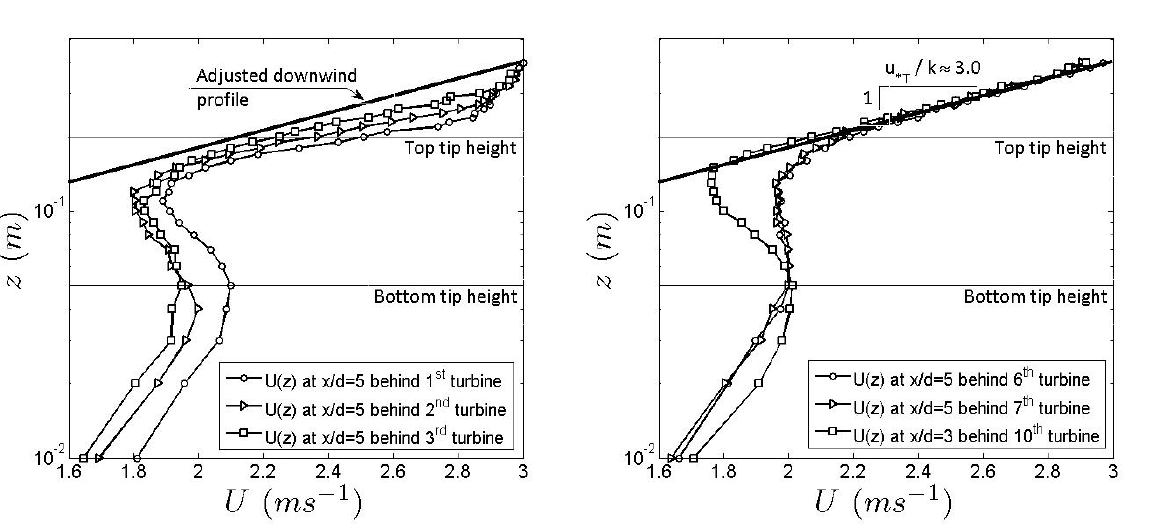
Figure 4. Non-adjusted ( left ) and adjusted ( right ) velocity distributions above the top tip in = 5 ). Horizontal lines represent the turbine bottom the wind farm at different locations ( S x and tip heights.